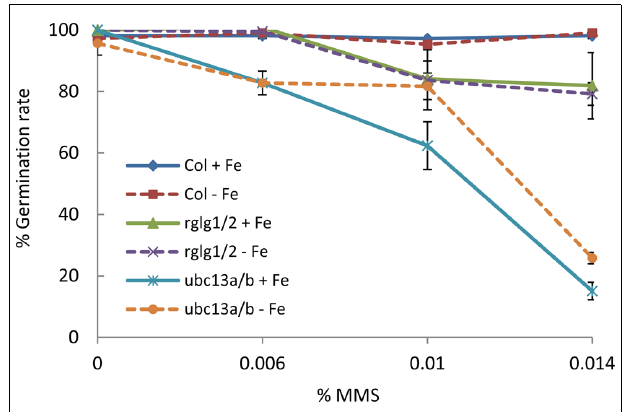
FIGURE 3 |Analysis of DNA damage response during seed germination. Seeds of wild-type plants, rglg1 rglg2 , and ubc13a ubc13b double mutants were placed on either iron-replete or iron-deplete media containing 0, 0.006%, 0.01%, and 0.014% MMS. Data points indicate the percentage of seed germination after 5 days with SD ( n =